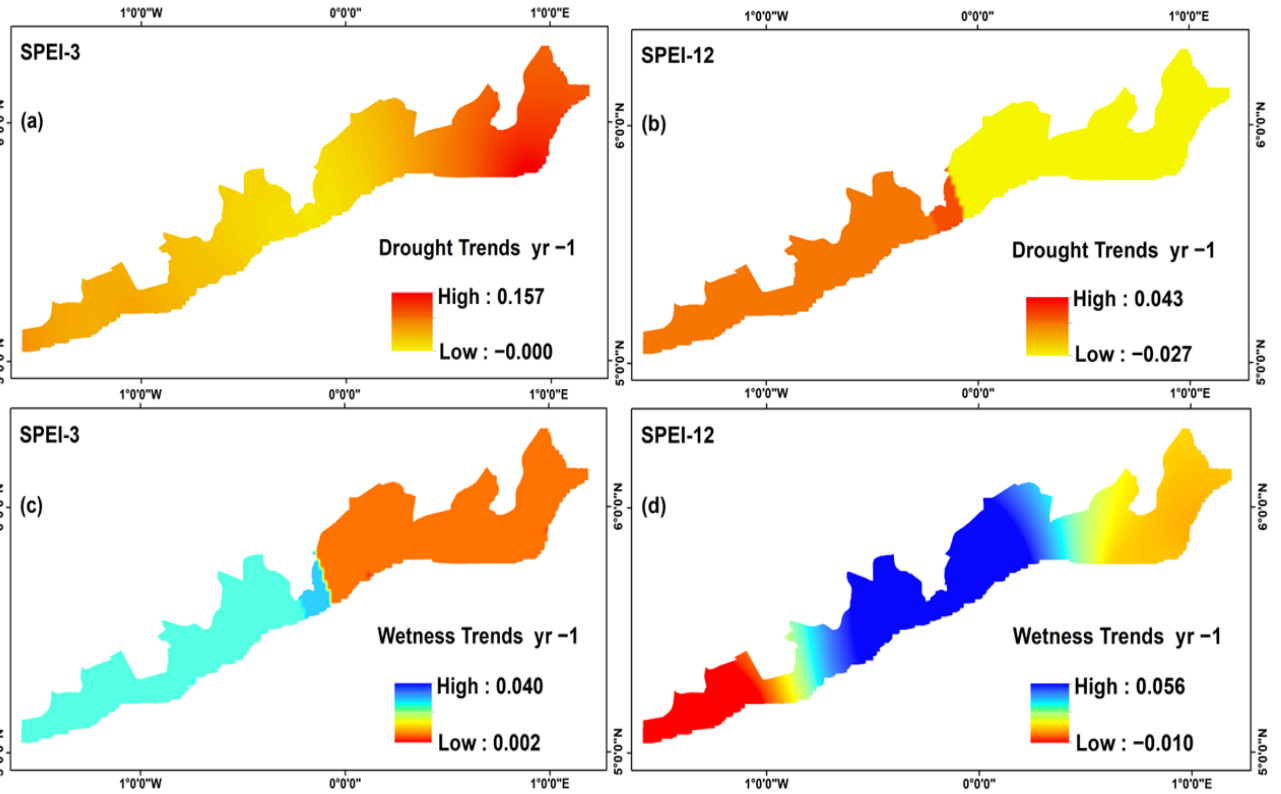
Figure 7. Spatial distribution of drought/wetness trends in the coastal Savannah agroecological zone of Ghana: Drought trends under ( a ) SPEI-3 and ( b ) SPEI-12 timescales; wetness trends under ( c ) SPEI-3 and ( d ) SPEI-12 timescales.